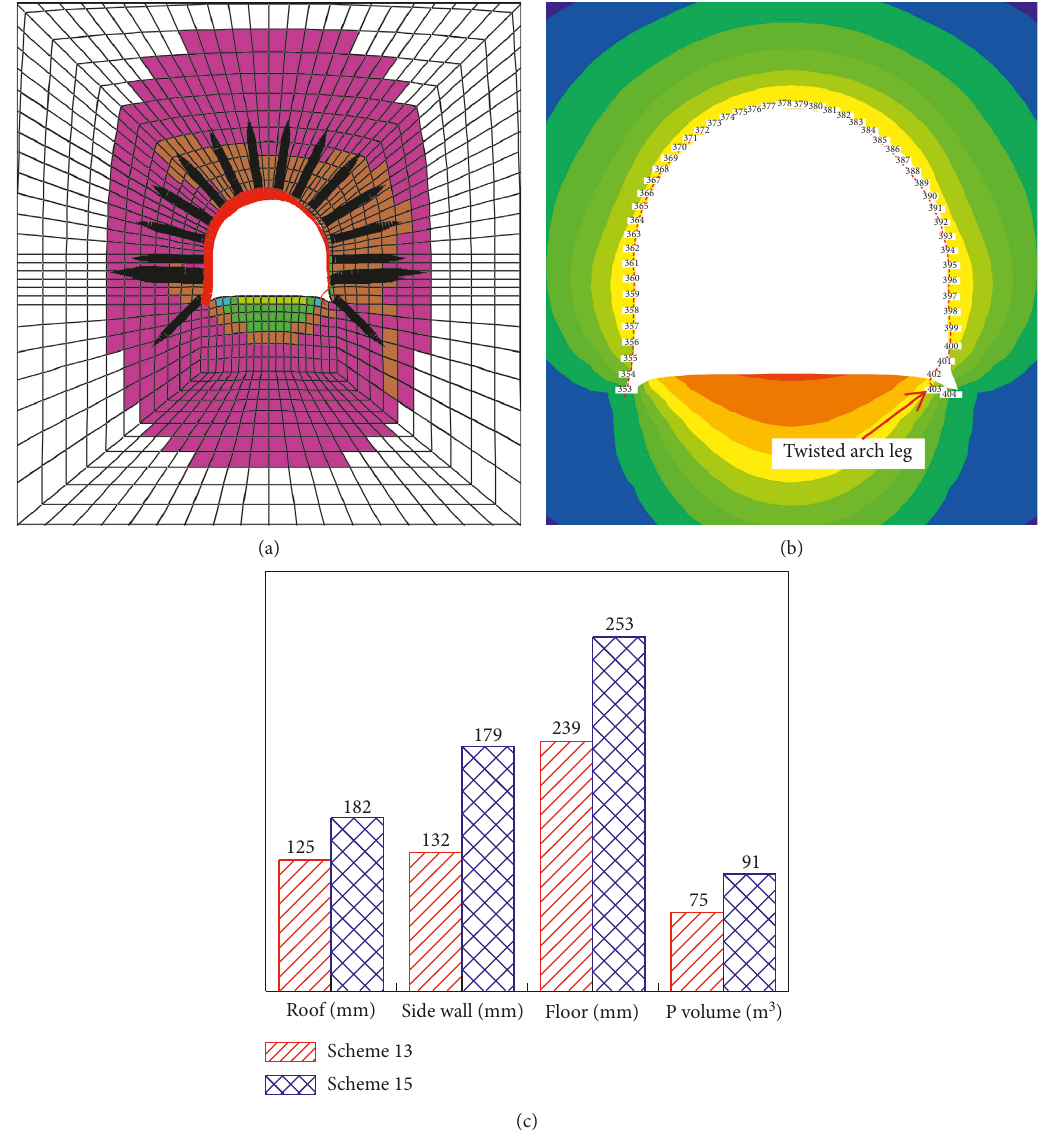
Figure 15: Main results of Scheme 15. (a) Surrounding rock plastic zone and supporting structure inner force diagrams. (b) Roadway displacement contour at the 50 th day. (c) Comparative columns of surrounding rock control effects of Scheme 13 and Scheme